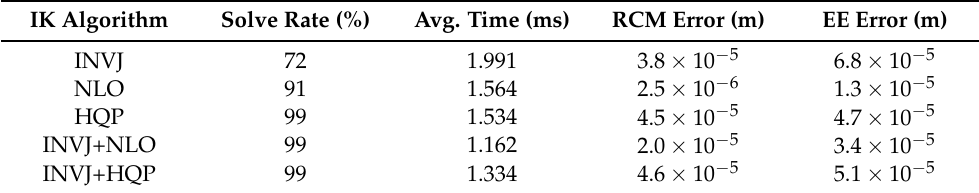
Table 7. A comparison of solve rate and time performance for single and concurrent IK algorithms considering all target